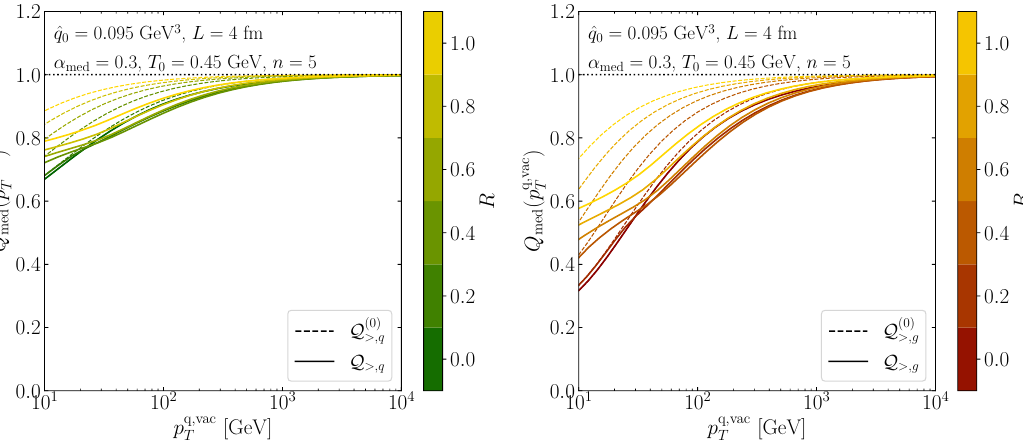
Figure 4 . The quantile ratio using the eq. (2.30) for a single parton quenching (dashed line) and quenching the whole jet with coherence effects from eq. (2.31) (solid line). Quark jets on the left and gluon jets on the right panel for different cone